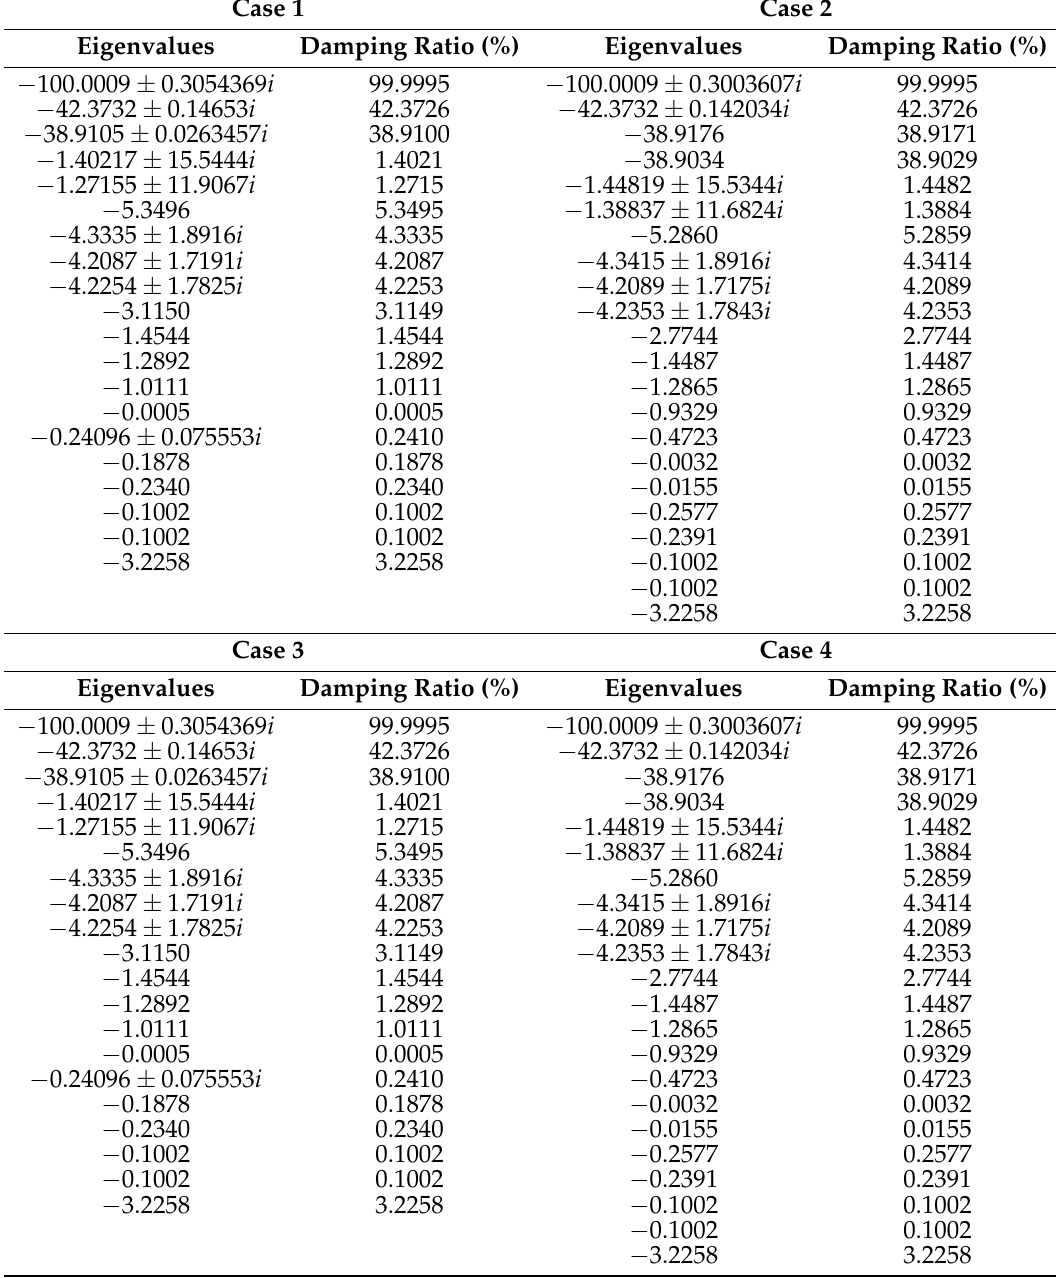
Table 5. Damping ratio percentages for Scenario